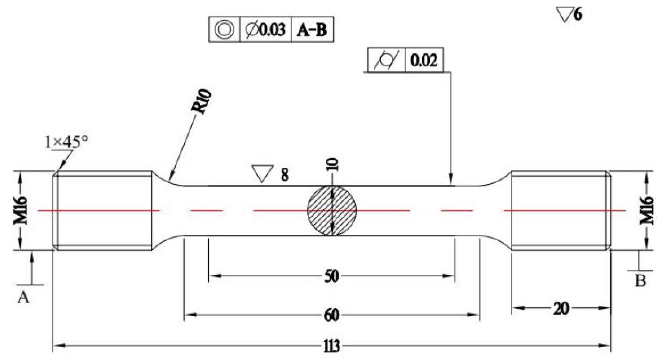
Figure 1. Sample size of high temperature tensile test.